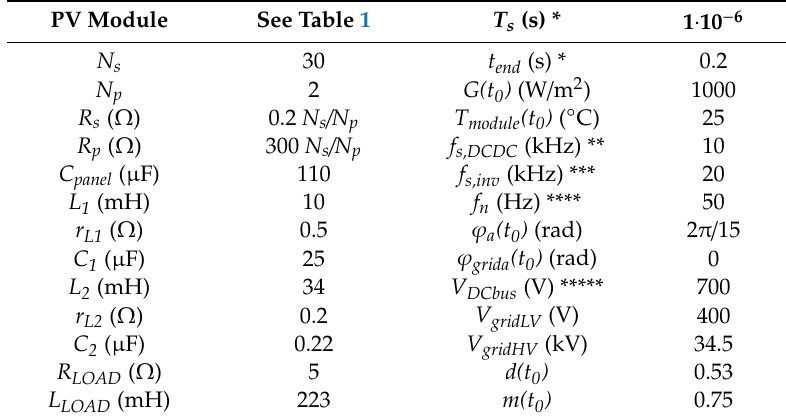
Table 2. Parameters list for the simulation shown in Figure